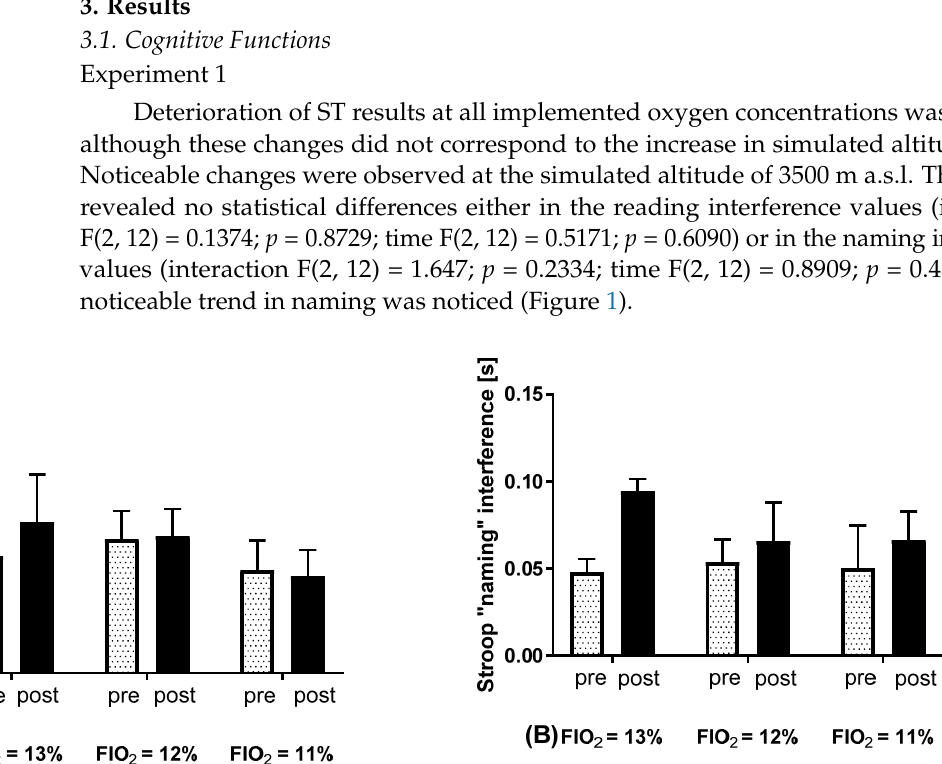
Figure 2. Effect of normoxia and acute normobaric hypoxia at FIO 2 = 13% on post-exposure inter- ference values in reading ( A ) and in naming ( B ). Subsections ( C , D ) represent their deltas. Values are means. Error bars indicate SEM (standard error of the mean). * p < 0.05; ** p < 0.01.